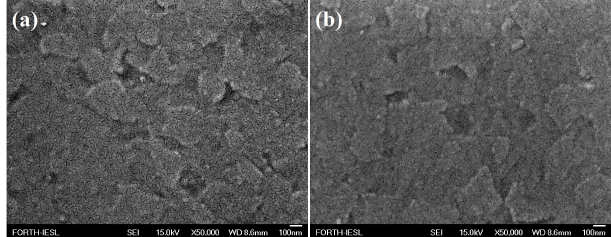
Figure 4. FE ‐ SEM images of the electrodeposited V 2 O 5 for electrolyte concentrations of 0.1 ( a ) and 0.2 M ( b ) at 1.3 mA ∙ cm − 2 for a magnification of ×50,000.